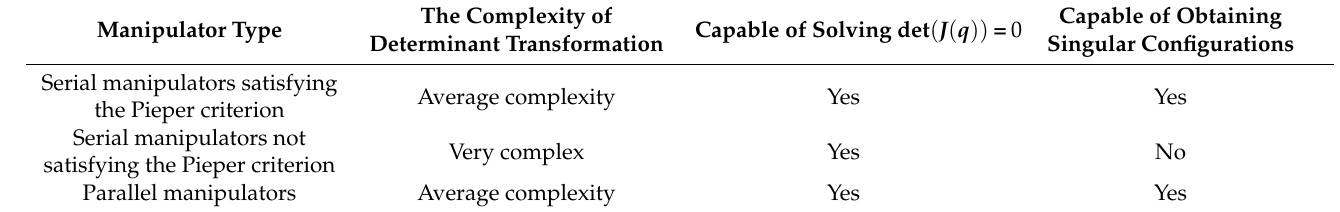
Table 6. Results for the analytical